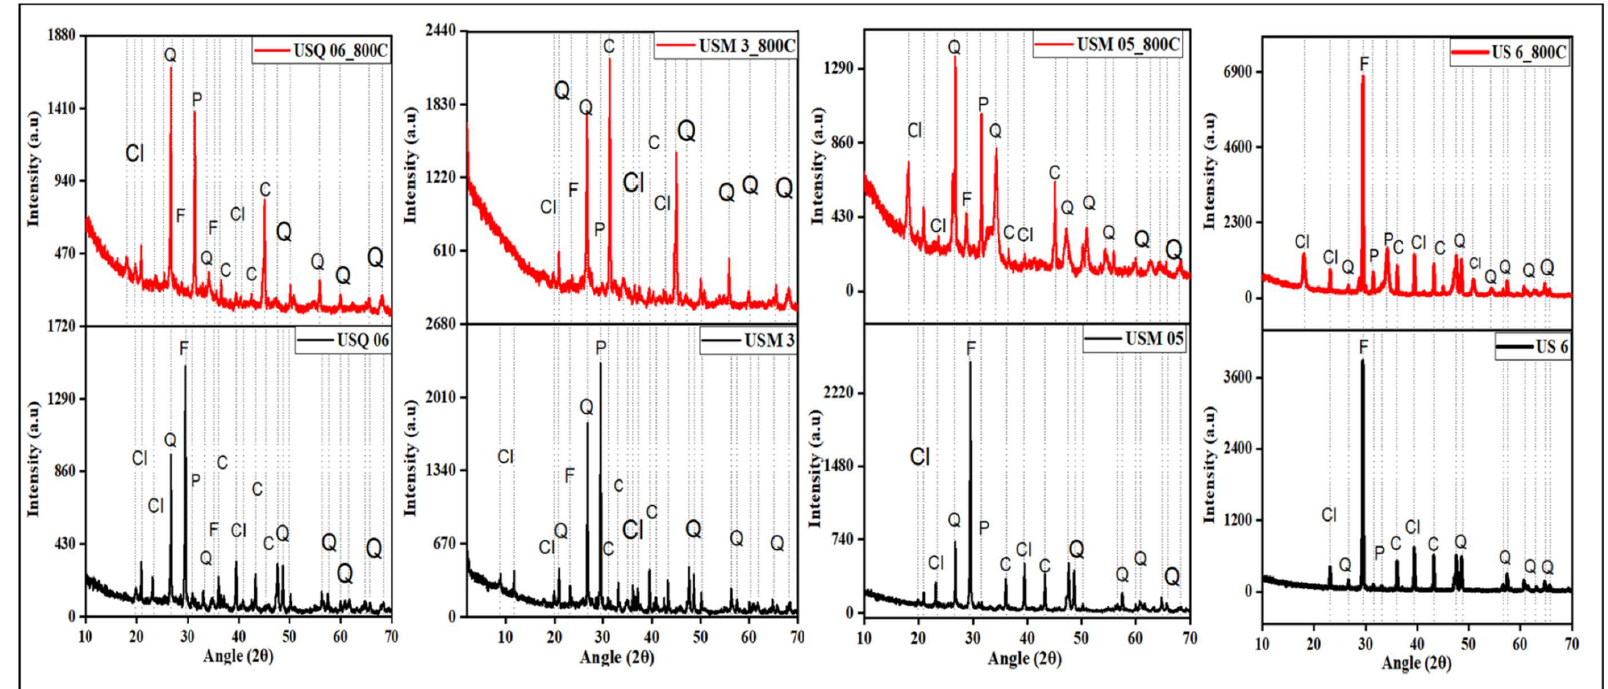
Figure 2. Impact of pyrolysis on the mineralogical content of the shale samples. L–R (USQ 06, USM 3, USM 05, and US 6), Cl = clay, Q = quartz, F = feldspar, P = pyrite, and C = carbonate